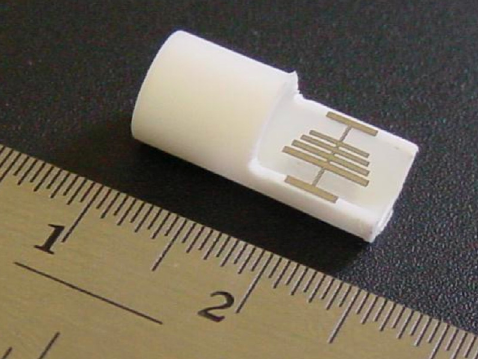
Figure 13. A four sensor magnetoelastic sensor array, laser-cut from a continuous ribbon. Reprinted with permission from